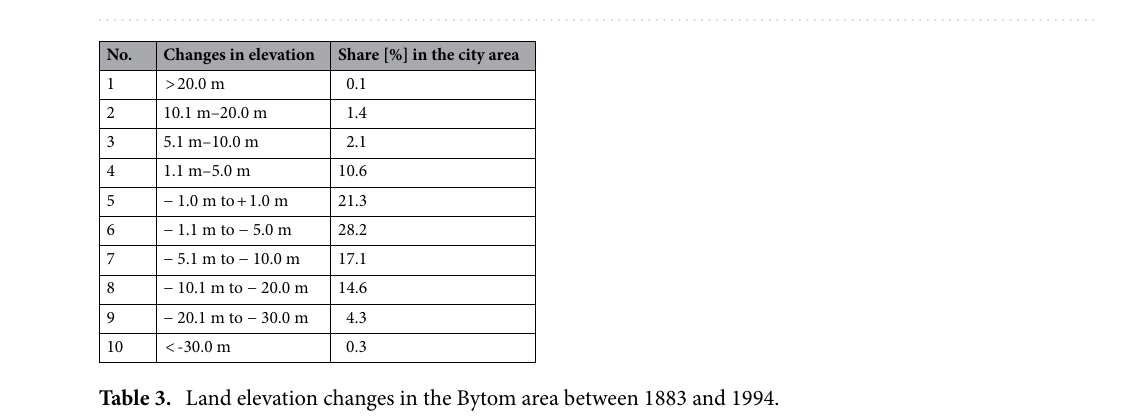
Figure 4. Changes in relative elevation within Bytom between 1883 and 1994: 1—city boundary; 2—elevation changes at selected height control points; 3—elevation changes within city limits.